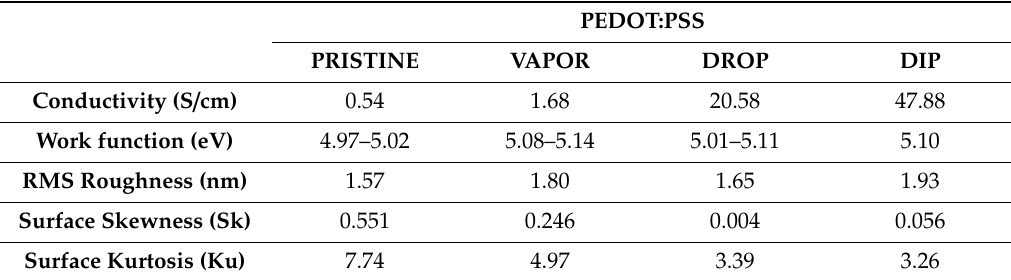
Table 2. Electrical and morphological characteristics of pristine PEDOT:PSS film and post-treated PEDOT:PSS